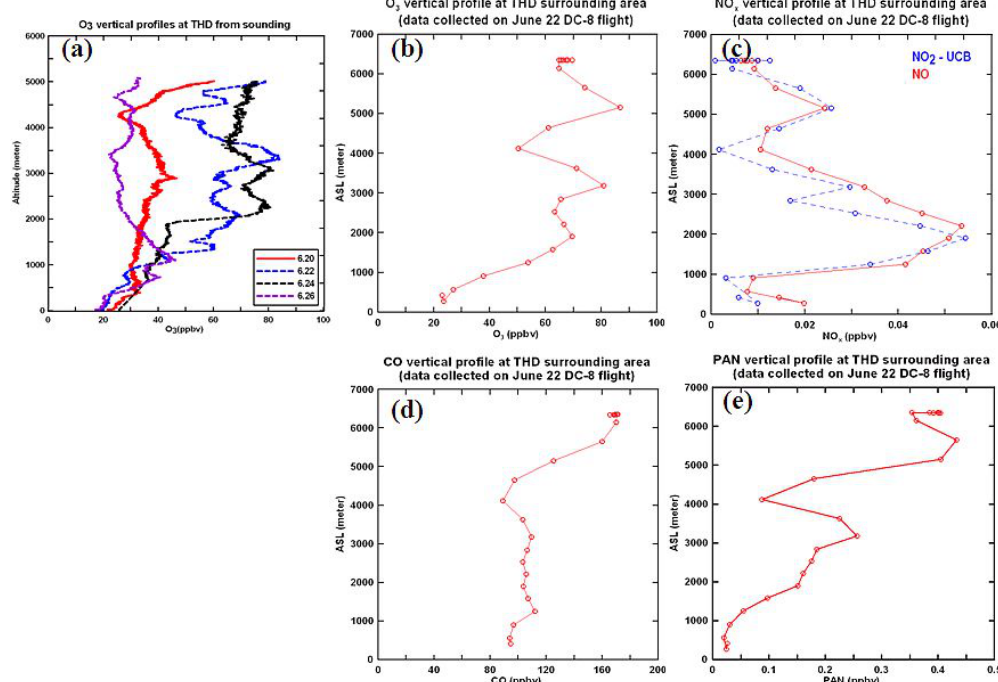
Fig. 5. (a) Observed O 3 vertical profiles at THD on four sounding days; (b) O 3 (c) NO x (d) CO (e) PAN vertical profiles on 22 June at THD surrounding areas, observed on